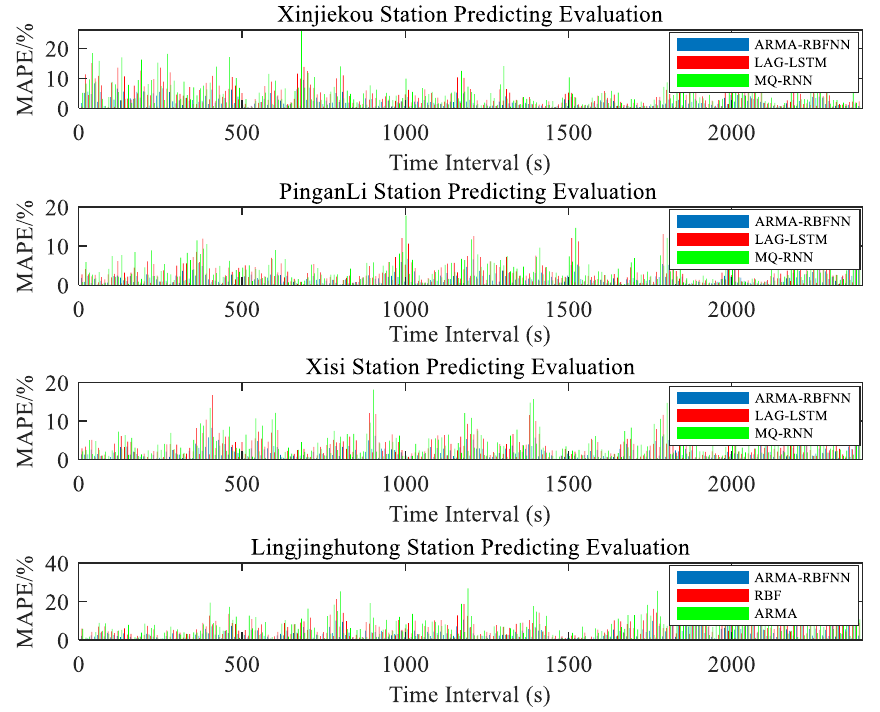
30 of 43 Figure 11. RBFNN algorithm parameters selection and performance results. ( a ) The prediction re- sults of four different stations; ( b ) ARMA-RBFNN performance results; ( c ) ARMA-RBFNN training state results; ( d ) ARMA-RBFNN regression results. Specifically, some commonly used time series prediction models (i.e., LSTM varia- tion (Yin, Ning and Tang [55]) and MQ-RNN (Wen et al. [56]) are selected as benchmark models. The benchmark models are detailed as follows. First, the LAG-LSTM parameters are set as learning rate = 0.002, batch size = 80, pervious time steps = 14 and time delay = 5. The dimension of the hidden state is set as 12. The dropout is 0.2 (Yin, Ning and Tang [55]). Next, MQ-RNN is constructed as a simple combination of state and control variables as input data for the standard RNN network. The parameters are set as 12 t h  and N = 14 (Wen et al. [56]). In order to evaluate the performance of different algorithms, the Mean Absolute Per- centage Error (MAPE) is selected as the evaluation index. As the ARMA-RBFNN algo- rithm predicts the passenger flow, it is necessary to evaluate the performance of this